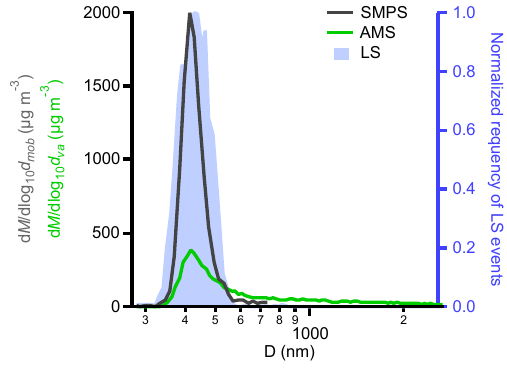
Figure 2. Ensemble mass distributions from SMPS (black trace, adjusted for density) and AMS (green trace) of size-selected α - pinene-derived SOA particles with 370nm mobility diameter for an example SOA experiment. Frequency of optically counted particles (from LSSP) as a function of size shown in blue. For this instance, CE m = 0.39. The blue trace is normalized to 1 and plotted on the right axis so as to have the same height as the SMPS trace, reflect- ing that optical detection in the AMS flight chamber is not affected by particle